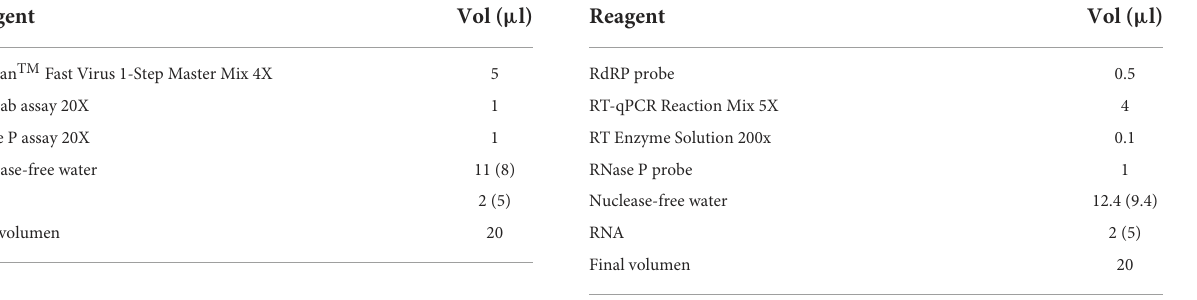
TABLE 1 Thermo Fisher RT-qPCR mix.